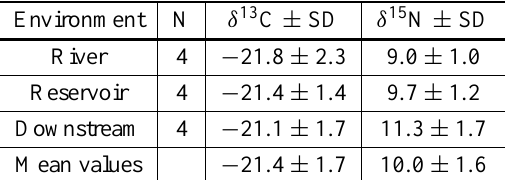
Means values of δ 13 C and δ 15 N ( rici sampled in the area of influence of Corumbá Reservoir (n = number of specimens, SD = standard